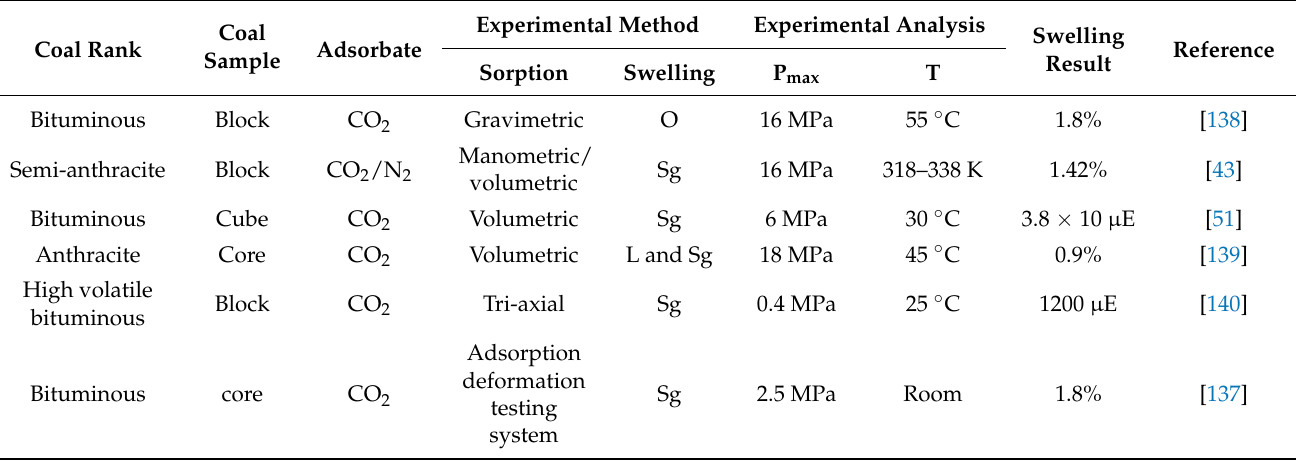
Table 1. Summary of experimental studies related to gas adsorption by coal. Sg: strain gauge, Sb: strain bridges, L: LVDT, O: optical and P max : maximum experimental